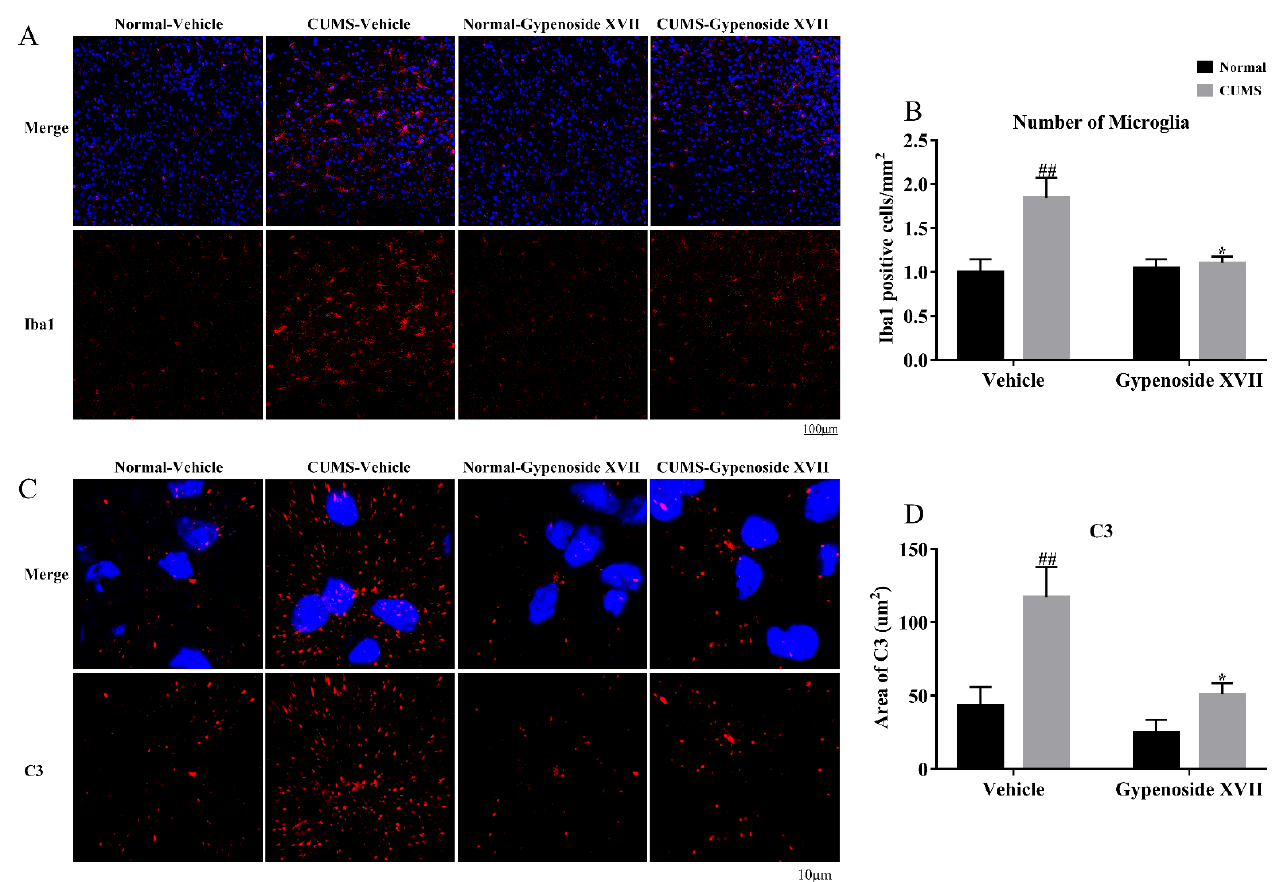
Figure 3. The number of microglia was decreased and the levels of C3 were decreased by Gypenoside XVII in the prefrontal cortex ( n = 4). The number of microglia ( A , B ) and the levels of C3 ( C , D ) were detected by immunofluorescence. ## p < 0.01 versus the Normal ‐ vehicle group. * p < 0.05 versus the CUMS ‐ vehicle group.